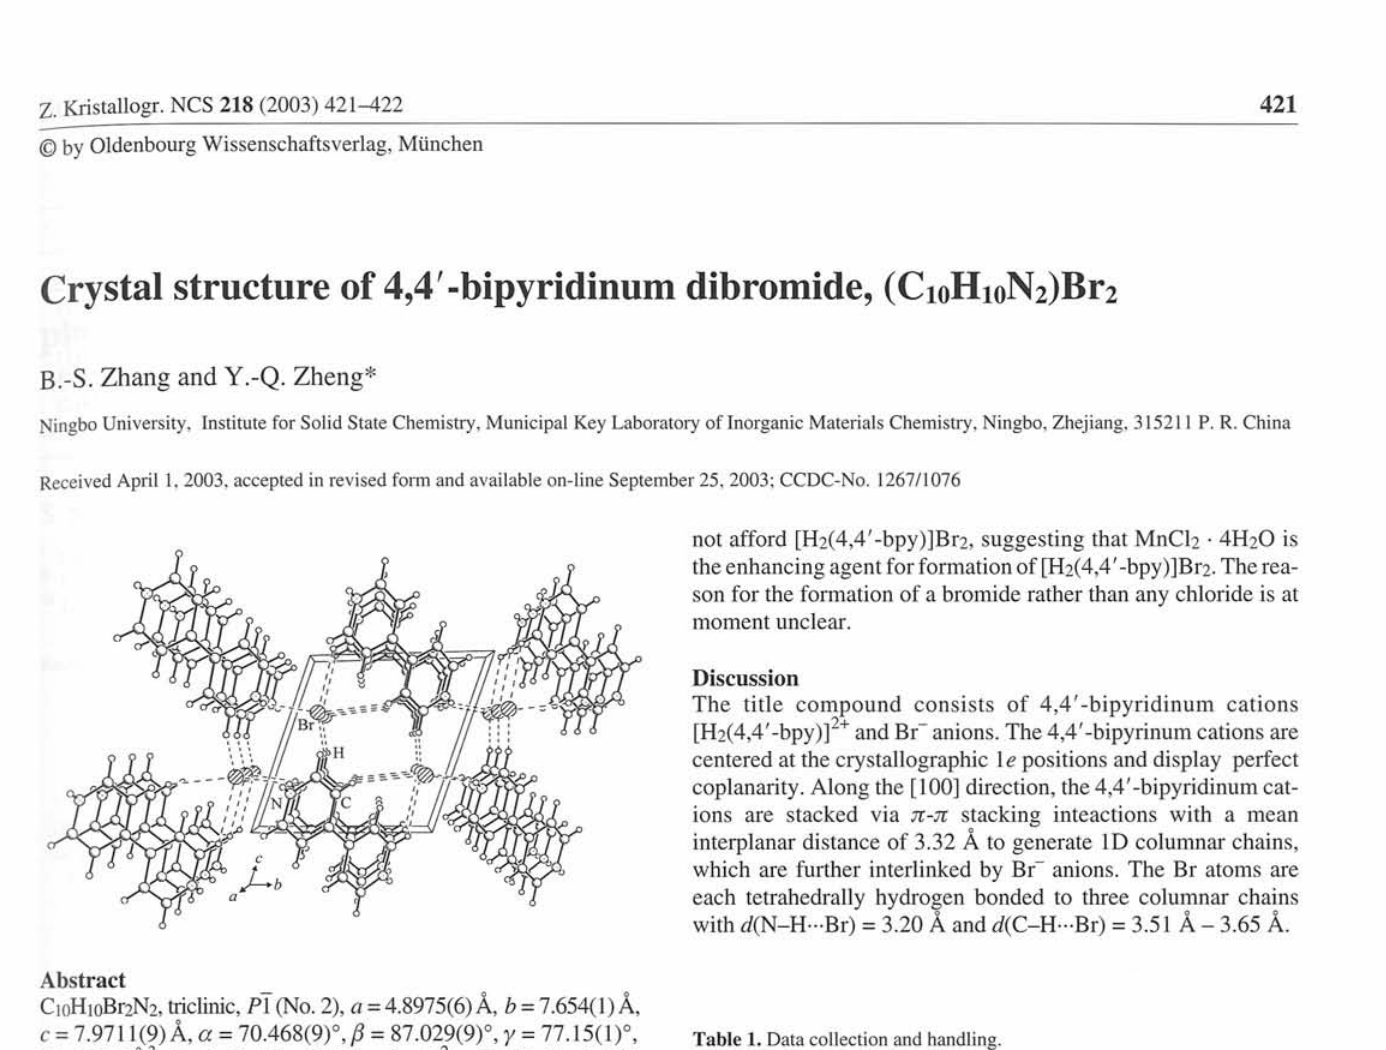
Table 1. Data collection and handling.